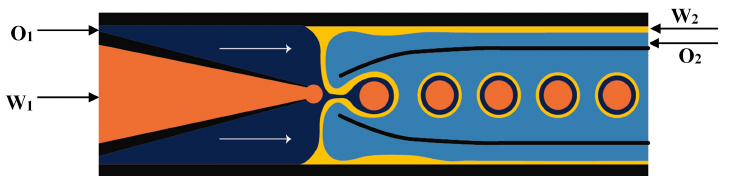
Figure 25. Glass capillary device for the preparation of W 1 /O 1 /W 2 /O 2 triple emulsion consisted of one injection capillary (at the left), one collection capillary (at the right) and one small capillary (not shown here) placed between the collection and outer capillary. All mentioned capillaries are inserted in a square outer capillary. The injection and collection capillaries are hydrophobic and the square outer capillary is hydrophilic [151].